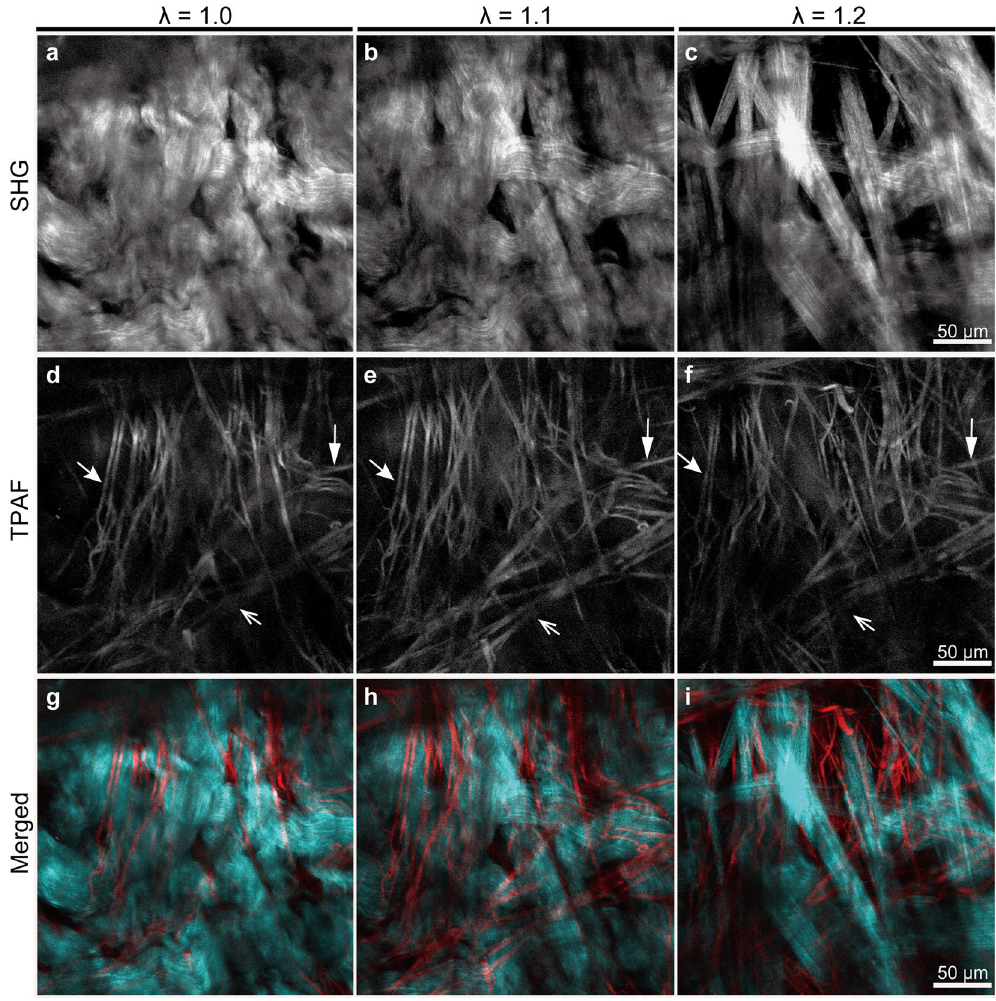
Figure 1. Dynamic multiphoton microscopy images of dermal fiber architecture under biaxial tissue extension. Second harmonic generation (SHG) images show architectural changes in collagen fibers ( a – c ) whereas two- photon autofluorescence (TPAF) images show architectural changes in elastic fibers ( d – f ). λ represents the stretch ratio. Arrows of the same shape indicate the same elastic fiber. Note that in TPAF images, the direction and shape of elastic fibers were maintained when stretched, whereas collagen fibers became linear with